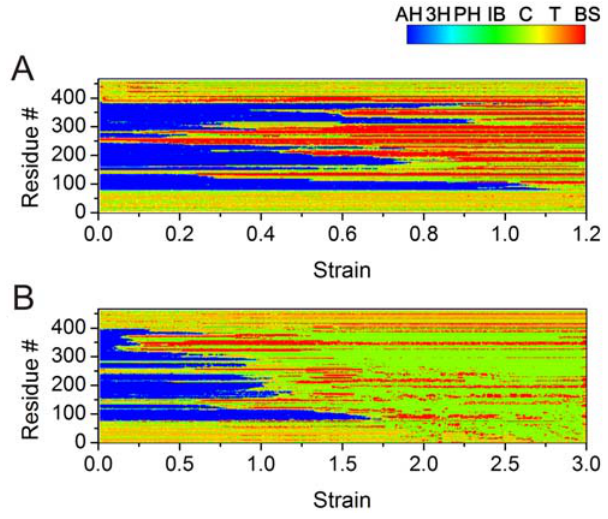
Figure 9. Structural spectrum of the vimentin dimer and tetramer, as a function of strain. The color bar indicates the structural character is separated into seven parts and corresponds to an a -helix (AH), 3–10 helix (3H), phi-helix (PH), isolated-bridge (IB), coil (C), turn (T) and a b -sheet (BS). Panel A: The spectrum of the structural transition of the vimentin dimer. The plot shows the structural character of each amino acid of a monomer (with 466 amino acids in total) in the vimentin dimer during the entire stretching process (due to the symmetric arrangement of the other monomer they show a same behavior, and is thus not shown). Panel B: The spectrum of the structural transition of the vimentin tetramer. The plot shows the structural character of each amino acid of a monomer (with 466 amino acids in total) in the vimentin tetramer during the entire stretching process (due to the symmetric and antisymmetric arrangement of the other three monomers, they show the same behavior, and are thus not shown). The analysis shows the gradual transition from an alpha-helix dominated structure (with unstructured and beta-sheet based linker/ head/tail domains) towards a beta-sheet rich structure. In the case of the vimentin tetramer, the onset of sliding at < 170% strain induces a reduction of the beta-sheet content as the strain is increased. The beta- sheets form many short segments in the overlapped region beyond this level of strain, leading to significant oscillations of the stretching force as shown in regime (IV) of Fig. 4B.